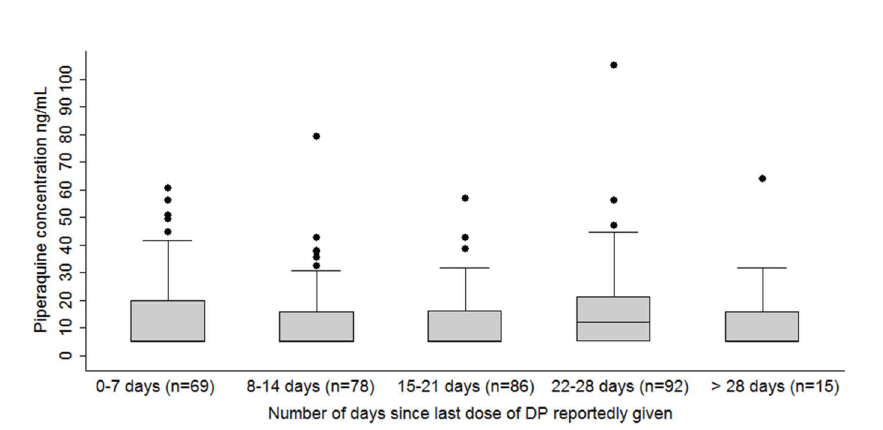
Figure 3. Vertical box plots of piperaquine concentrations at the time of each episode of malaria, stratified by number of days since last dose of DP reportedly given. 10 ng/ml represents the lower limit of detection.